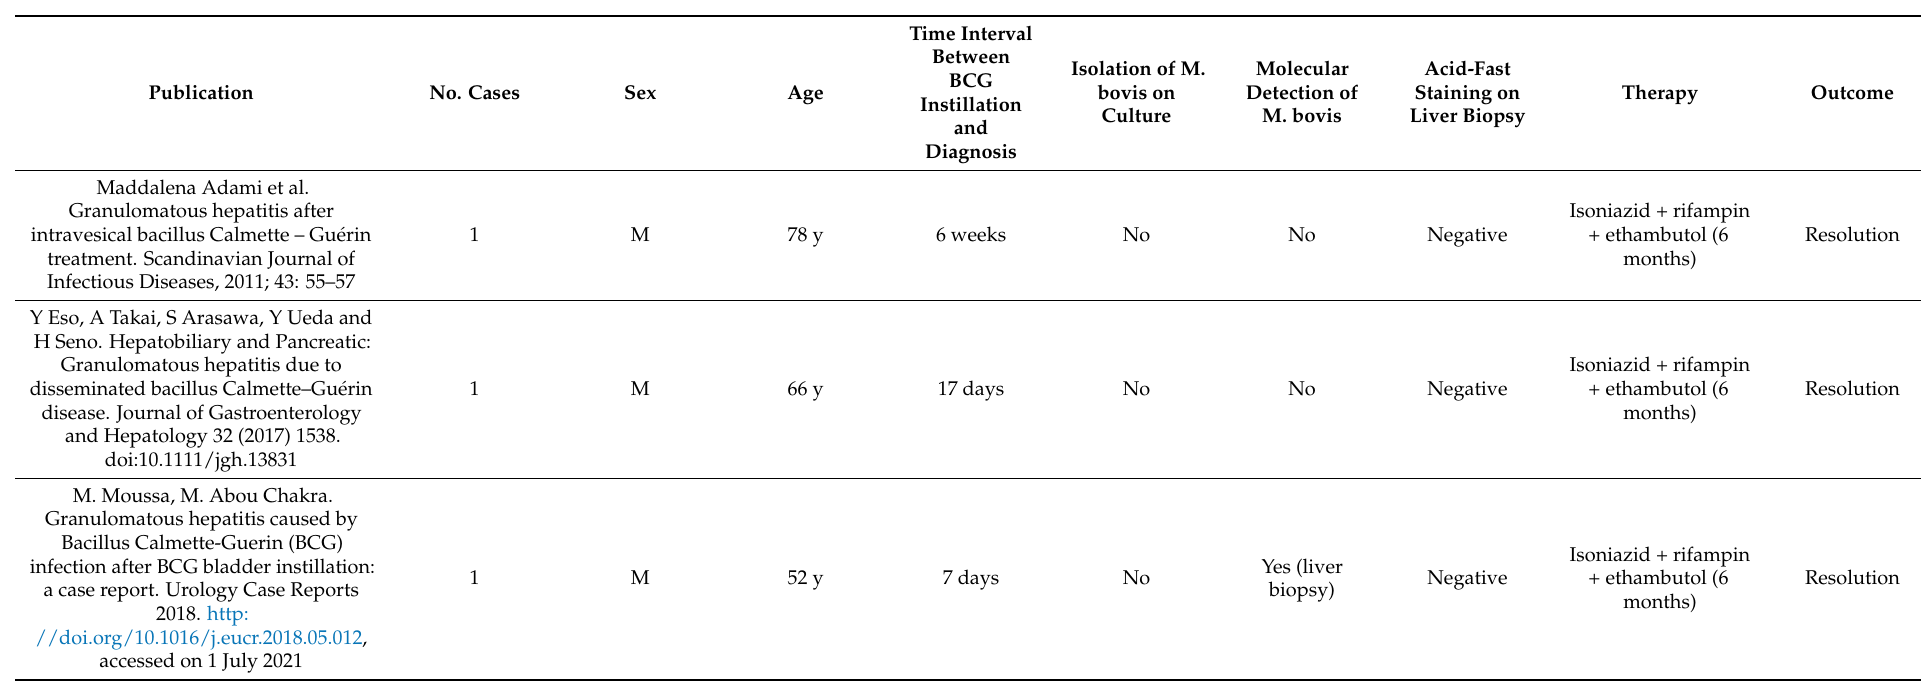
Table 3. Summary of some cases of granulomatous hepatitis following intra-vesical BCG therapy published in the